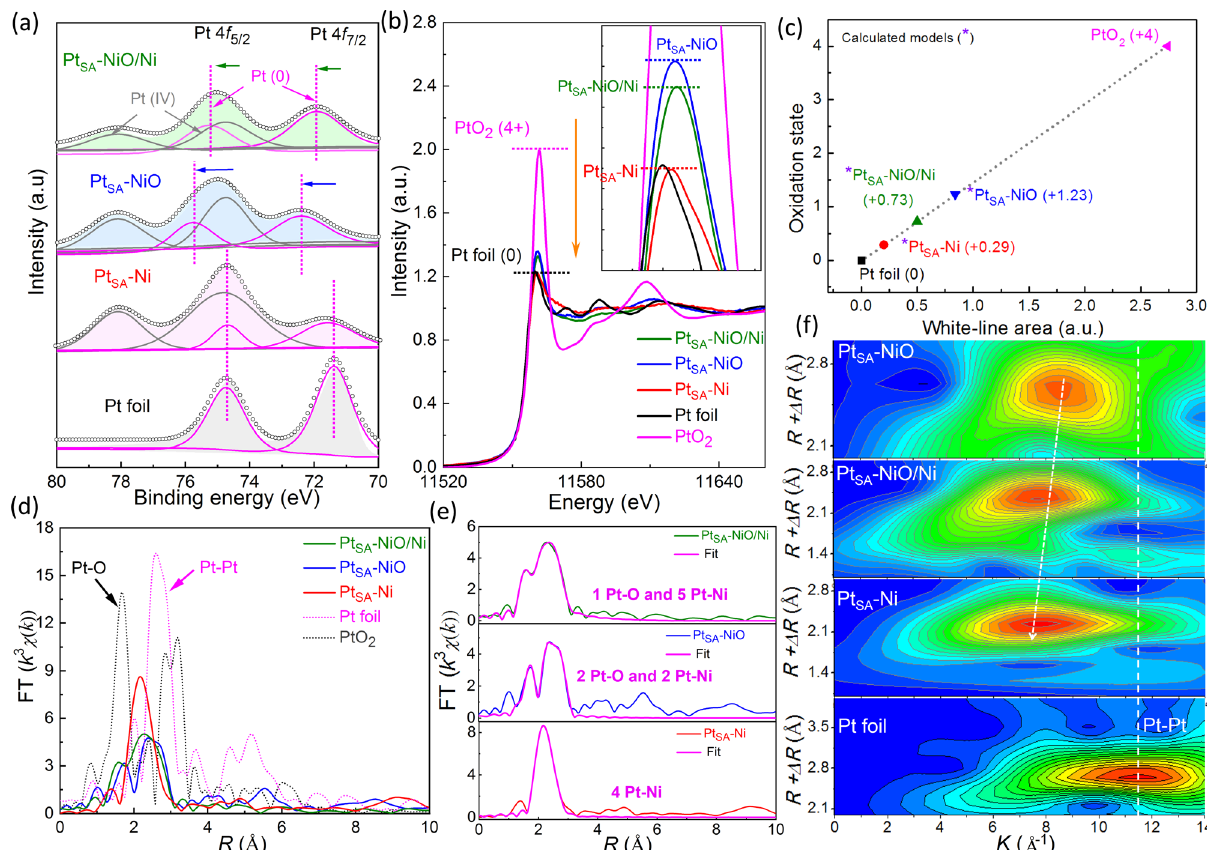
Fig. 3 Electronic state and atomic structure characterization. a Pt 4 f spectra, b XANES spectra, and c calculated Pt oxidation states derived from Δ XANES spectra of Pt SA -NiO/Ni, Pt SA -NiO, and Pt SA -Ni, and Pt foil is given as a reference. d Corresponding FT-EXAFS curves of Fig. 3b. e EXAFS fi tting curve of Pt SA -NiO/Ni, Pt SA -NiO, and Pt SA -Ni R -space. f EXAFS wavelet transform plots of Pt SA -NiO/Ni, Pt SA -NiO, Pt SA -Ni, and Pt